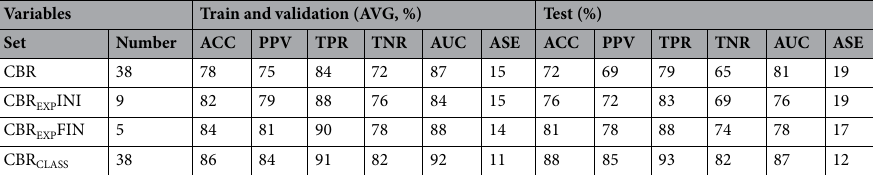
Table 2. Performance of gradually reduced expert set of variables for CBR